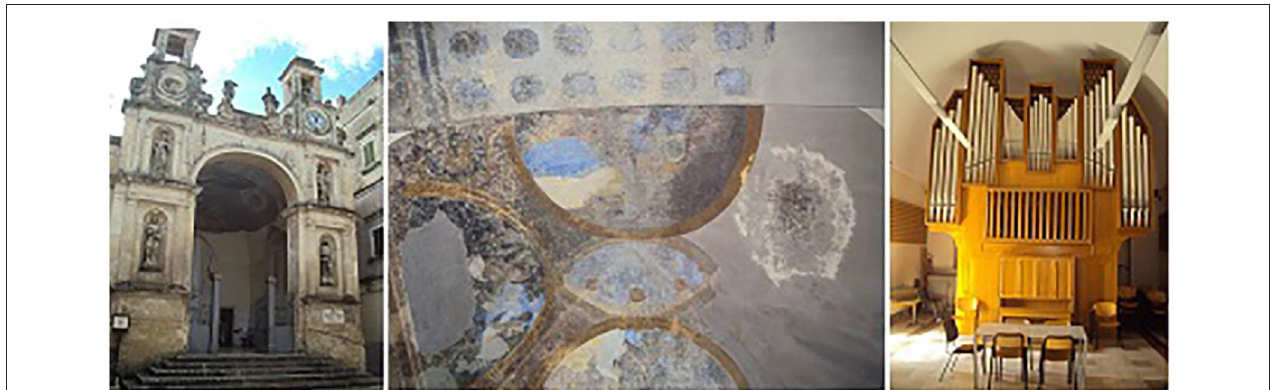
FIGURE 2 | “Sedile”